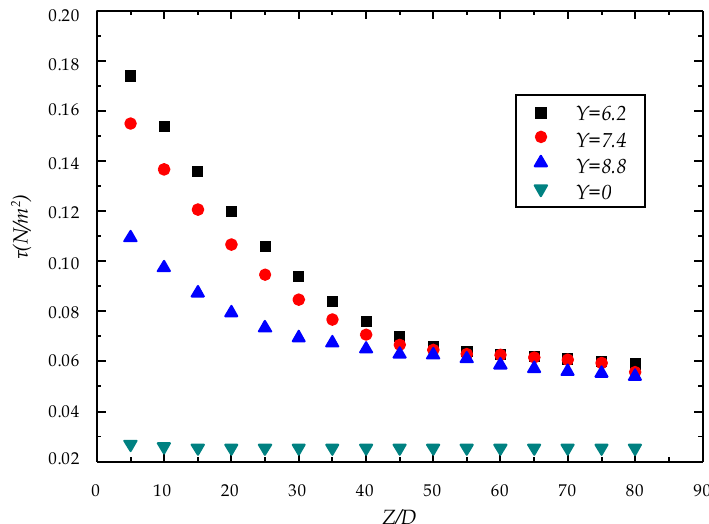
Figure 15 . When Re = 20,000, the shear force changes at different positions of different twist rates.